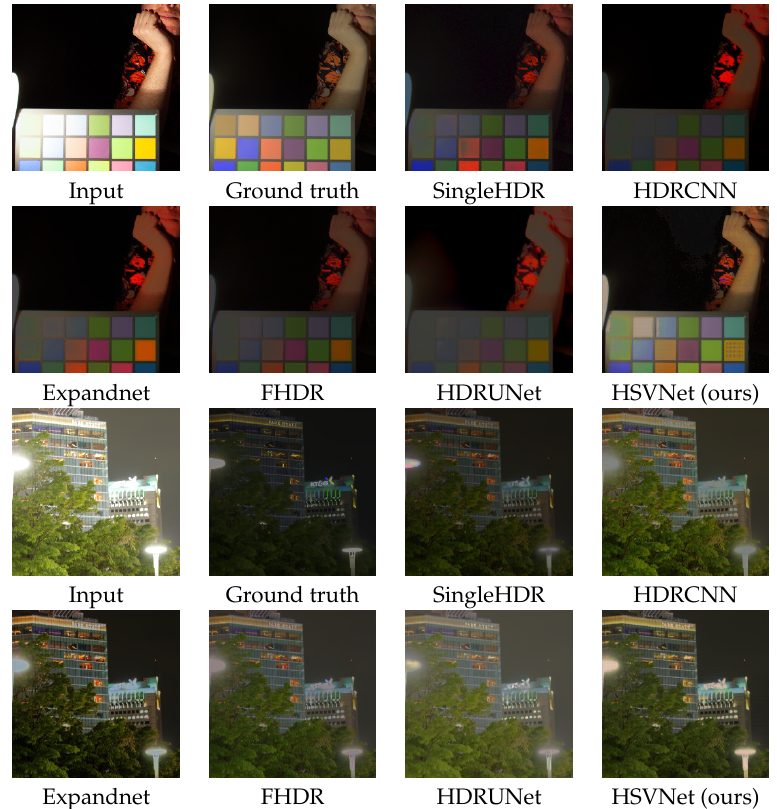
Figure 13. The result images in which our method did not successfully infer missing